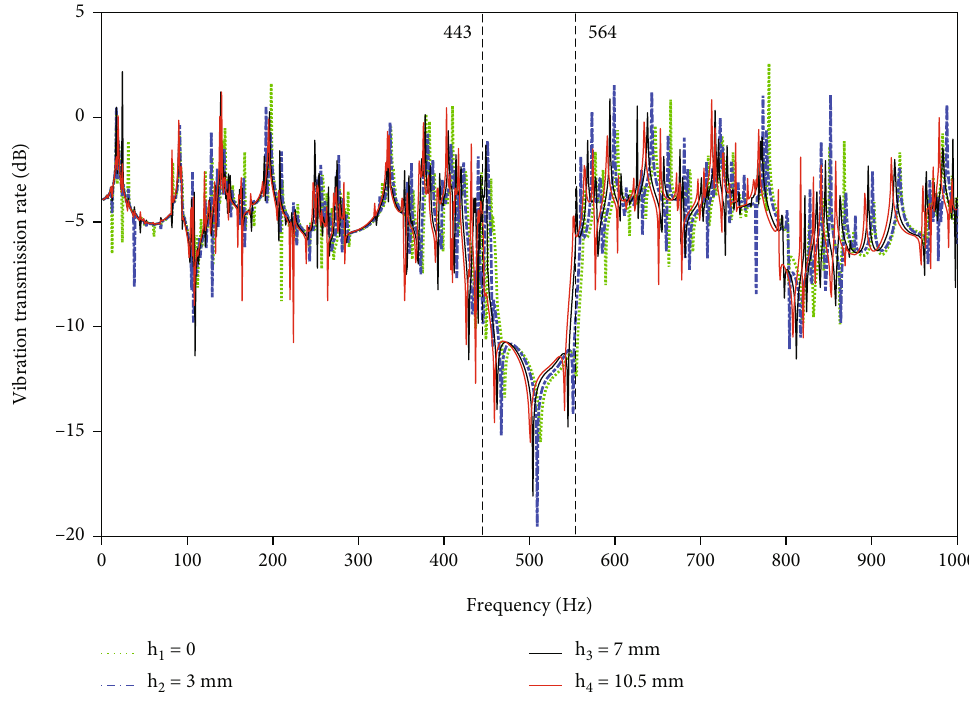
Figure 9: Vibration transmission rate of node R corresponding to the changes in the thickness of the embedded part.